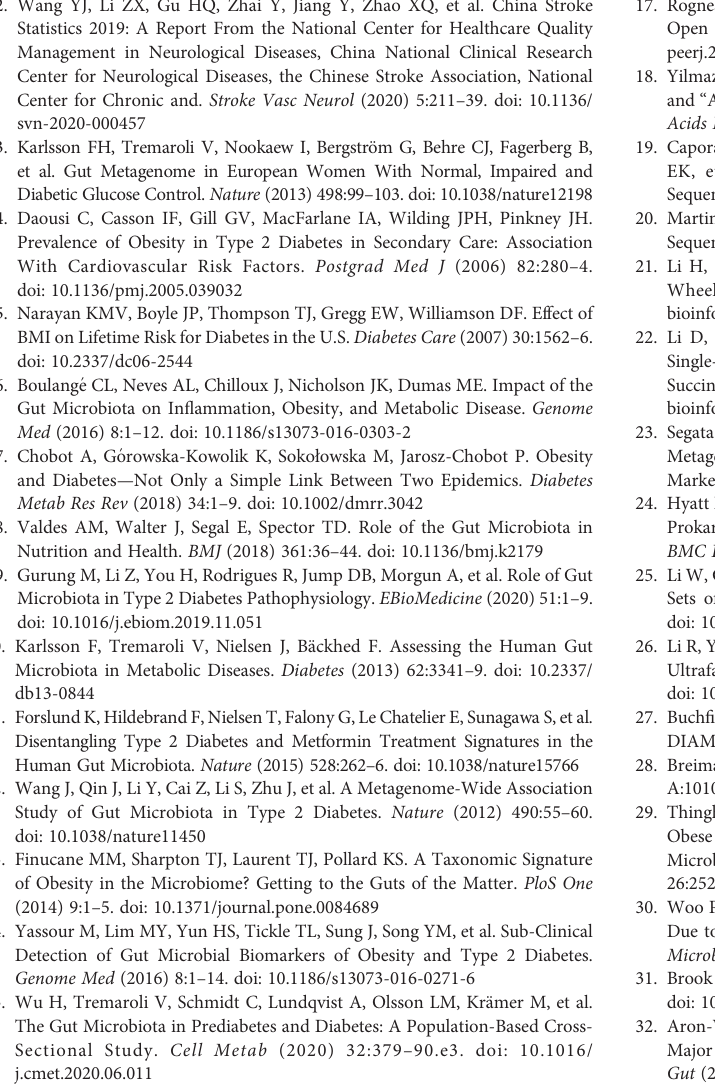
Supplementary Figure 3 | Relative abundance of indicated gut microbial phylum in Ob&H and Ob&T2D. (A-C) , Relative abundance of phylum Bacteroidetes (A) , Firmicutes (B) and Proteobacteria (C) in Ob&H and Ob&T2D gut microbiota. Data are shown as means ± SD. All P-values are from Wilcoxon rank-sum tests. Supplementary Figure 4 | Relative abundance of indicated gut microbial genera in Ob&H and Ob&T2D. (A-C) , Relative abundance of genus Bacteroides (A) , Faecalibacterium (B) and Bi fi dobacterium (C) in Ob&H and Ob&T2D gut microbiota. Data are shown as means ± SD. All P-values are from Wilcoxon rank-sum tests. Supplementary Figure 5 | Relative abundance of representative butyrate producer microbiota in Ob&H and Ob&T2D. (A – E) Relative abundance of specie Eubacterium rectale (A) , Eubacterium hallii (B) , Faecalibacterium prausnitzii (C) , Roseburia intestinalis (D) and Roseburia inulinivorans (E) in Ob&H and Ob&T2D. All P values are from Wilcoxon rank- sum tests.